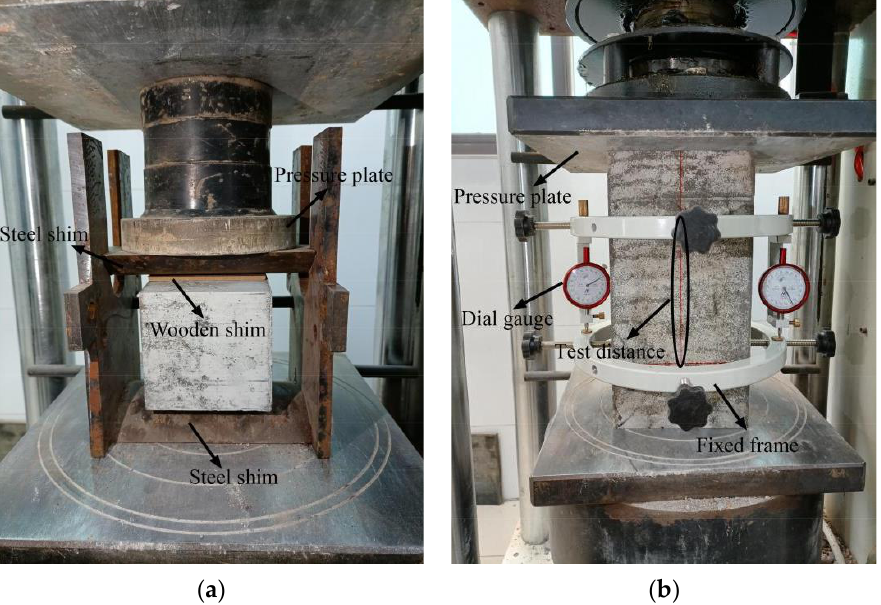
Figure 7. Mechanical property test setup: ( a ) Splitting tensile test; ( b ) Elastic modulus test.